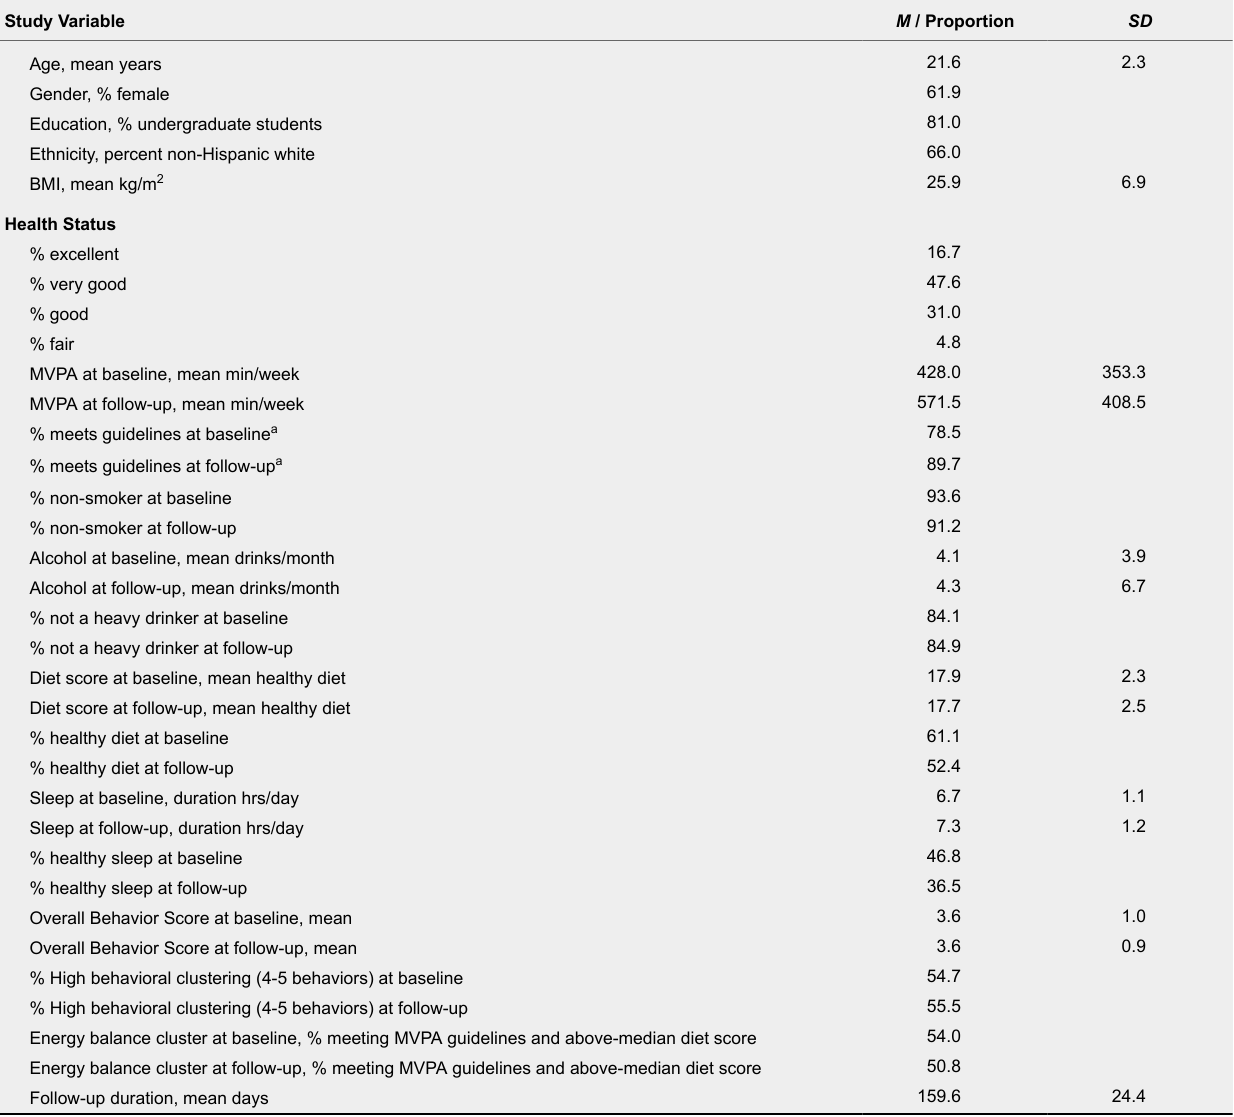
Characteristics of the Study Sample (N =